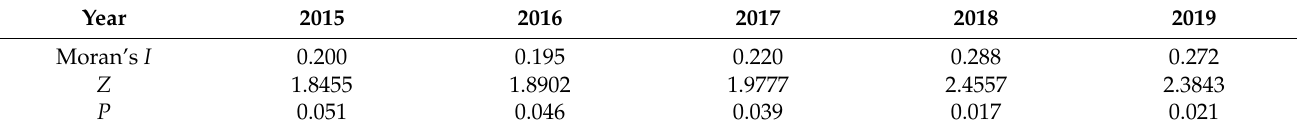
Table 7. The global Moran’s I value of the efficiency of medical and health services in Jiangsu Province from 2015 to 2019.